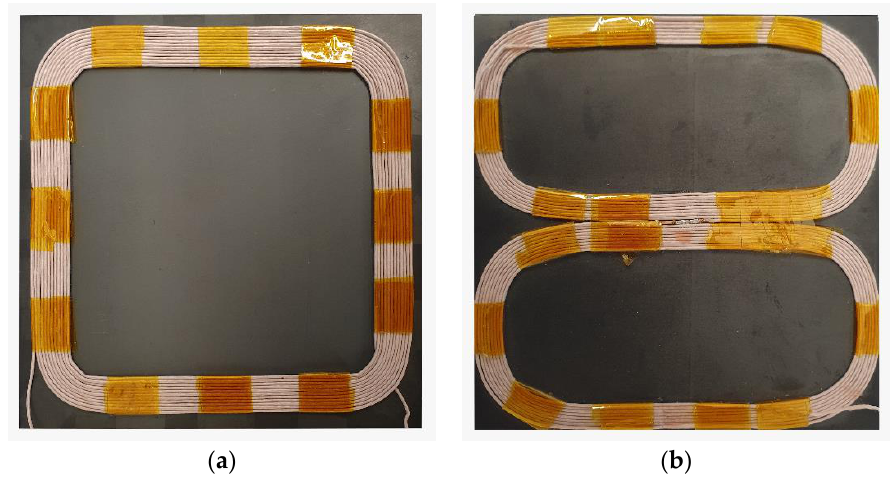
Figure 18. Transmitter coils under test: ( a ) Square planar coil; ( b ) DD coil.